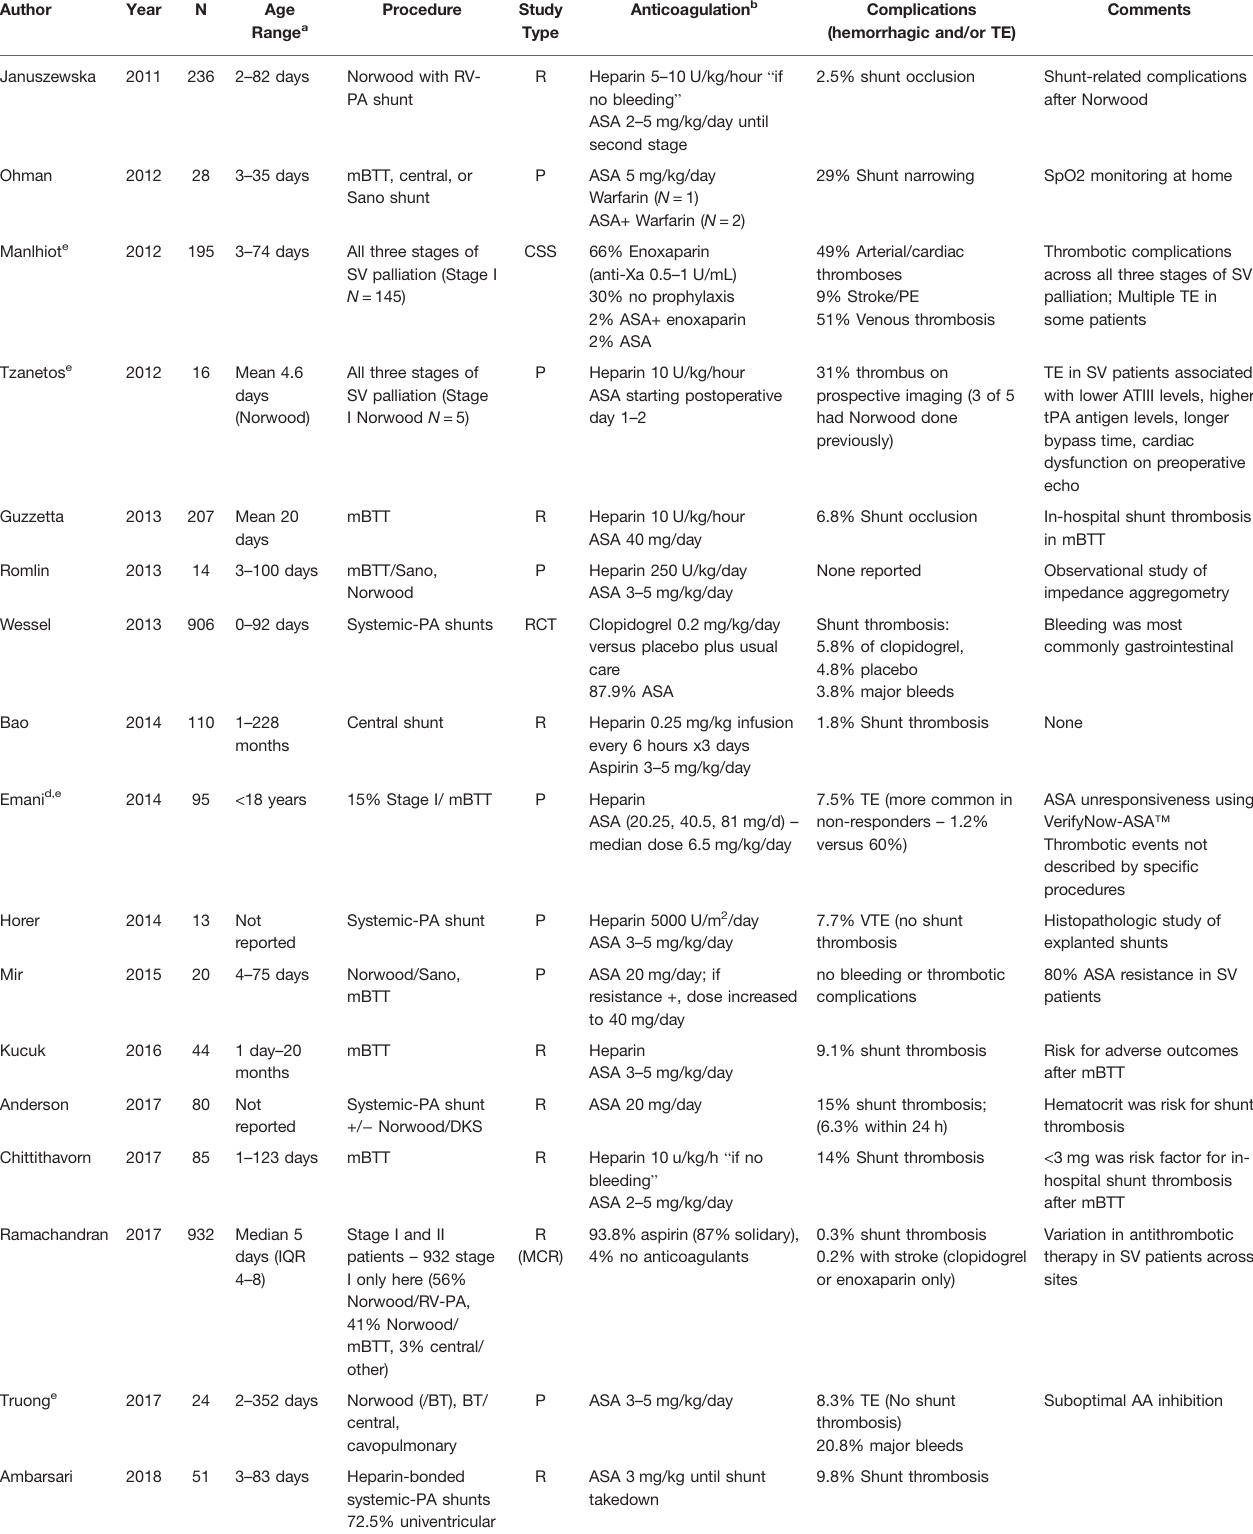
TABLE 2 | Shunt study